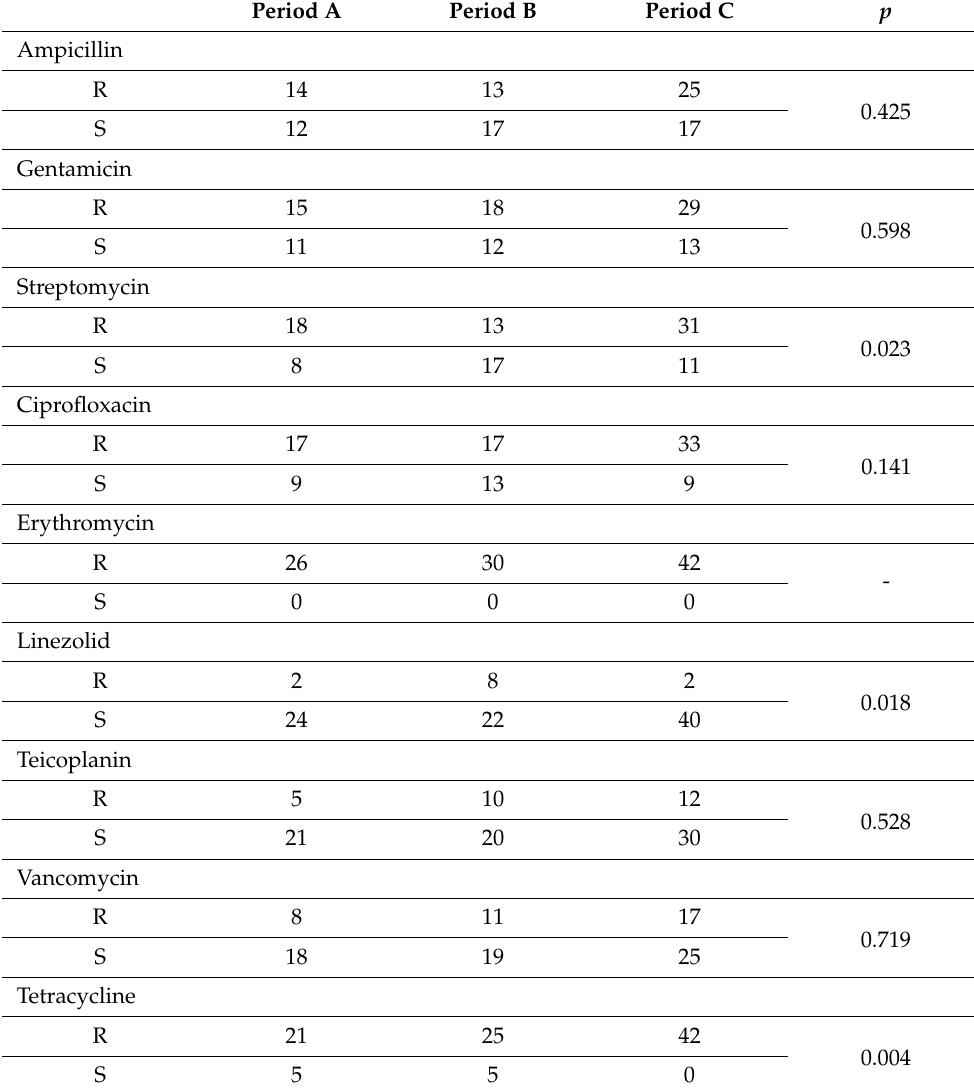
Table 7. Results of antibiotic susceptibility testing (AST) for all strains of Enterococcus spp. during the 18 months of the